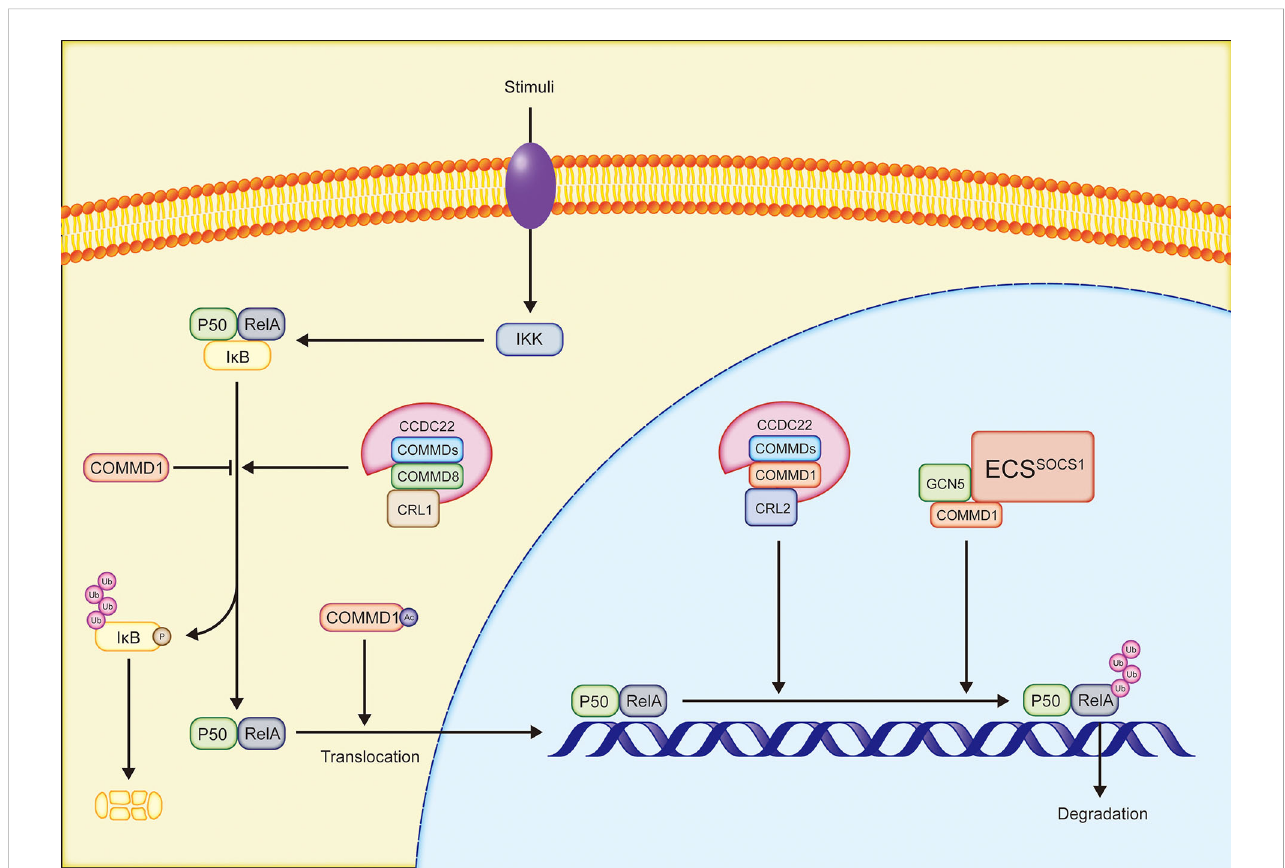
FIGURE 2 Simpli fi ed overview of the regulation of NF- k B pathway by COMMD proteins: COMMD, copper metabolism MURR1 domain-containing; CCDC22, coiled-coil domain-containing protein 22; CRL, Cullin-RING ligase; IKK, I k B kinase complex; GCN5, general control non-repressed protein